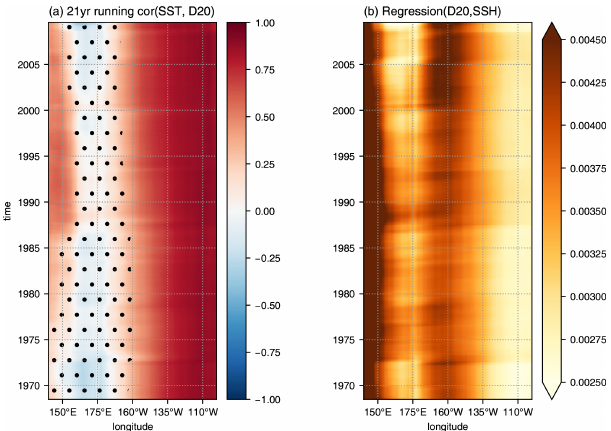
Figure 9. (a) The correlation in running 21-year windows between anomalies of SST and D20 from the NEMO model simulation. The time series have been detrended in each window separately. Dots indicate regions where the correlation is not significantly different from 0 at the 95% level. (b) The coefficient, in running 21-year windows, obtained by regressing D20 on sea surface height from the NEMO model simulation. The time series have been detrended in each window separately. The regression slopes are significantly different everywhere from 0 at the 95%